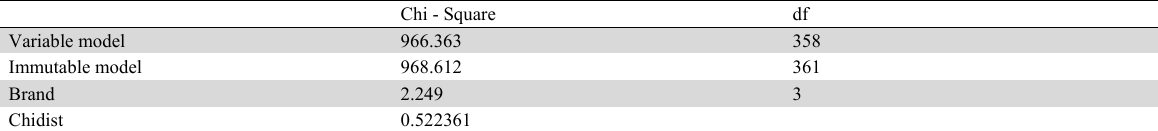
Results of the test of the throttling of business strategies on the impact of market orientation on the performance of Viet- namese startups